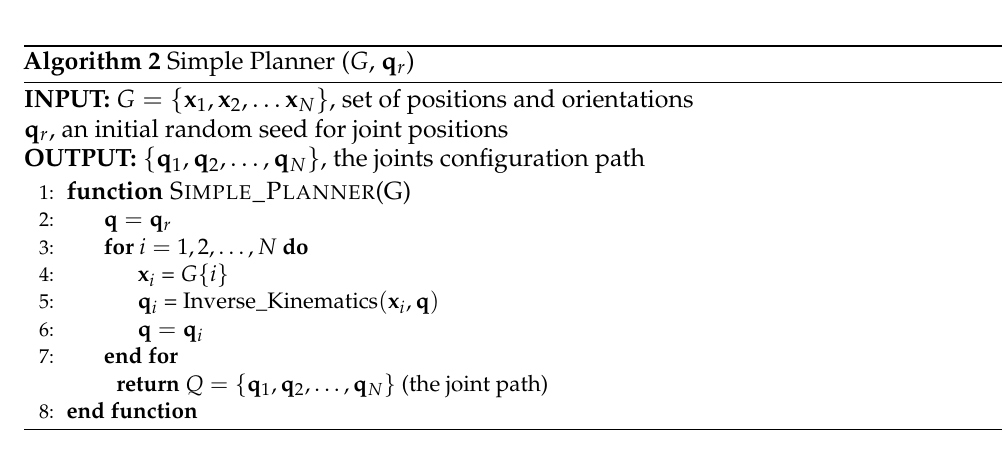
Algorithm 3 Inverse Kinematics( x i , q r